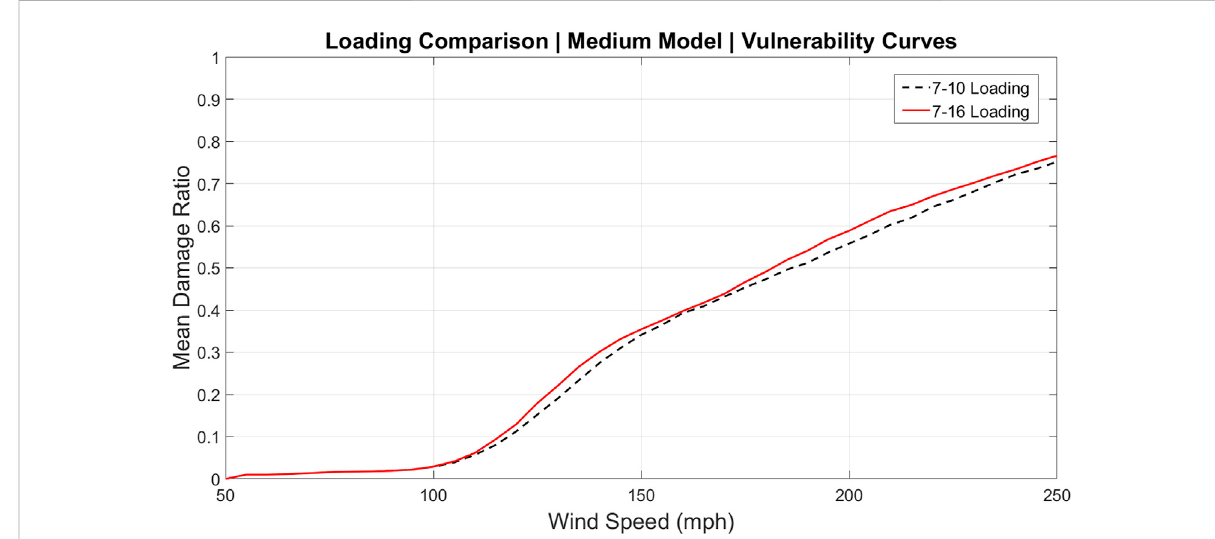
FIGURE 4 Vulnerability curves of the medium model using ASCE 7 – 10 and ASCE 7 – 16 loading.